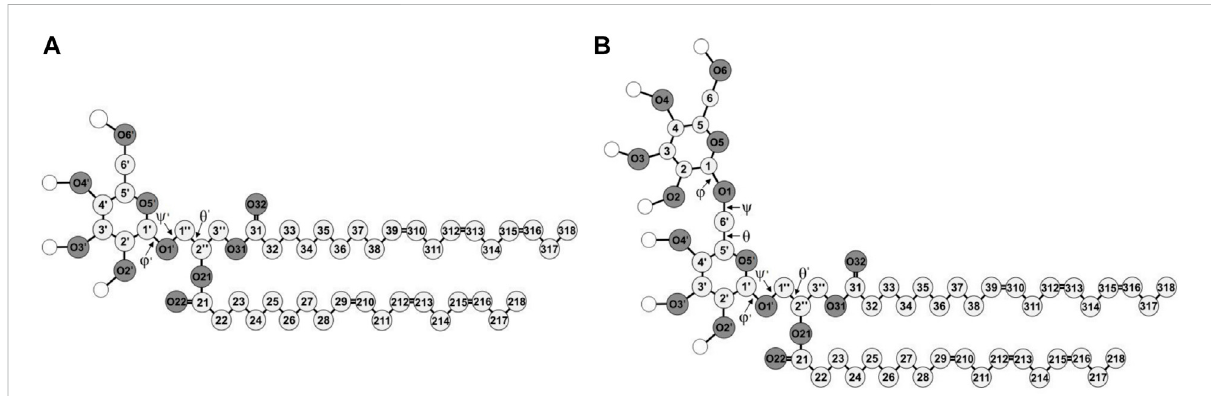
FIGURE 1 Molecular structures of di-18:3- cis (A) MGDG and (B) DGDG. The numbering of the acyl chains and glycerol backbone atoms is according to Sundaralingam ’ s nomenclature (Sundaralingam, 1972), with an exception for the C1 ″ and C3 ″ carbon atoms that are swapped here. The numbering of the galactose ring atoms is according to IUPAC convention (McNaught, 1996). The numbers of the carbon and oxygen atoms of the β ring are marked with ′ and the C1, C2 and C3 atoms of the glycerol backbone are marked with ″ to distinguish the atoms of the α and β galactose rings andoftheglycerol.The chemical symbolfor carbonatoms,C,isomittedandthehydrogenatomsarenotshown exceptfor thepolaronesshown as empty circles. Oxygen (O) atoms are dark and the carbon atoms are light grey circles,